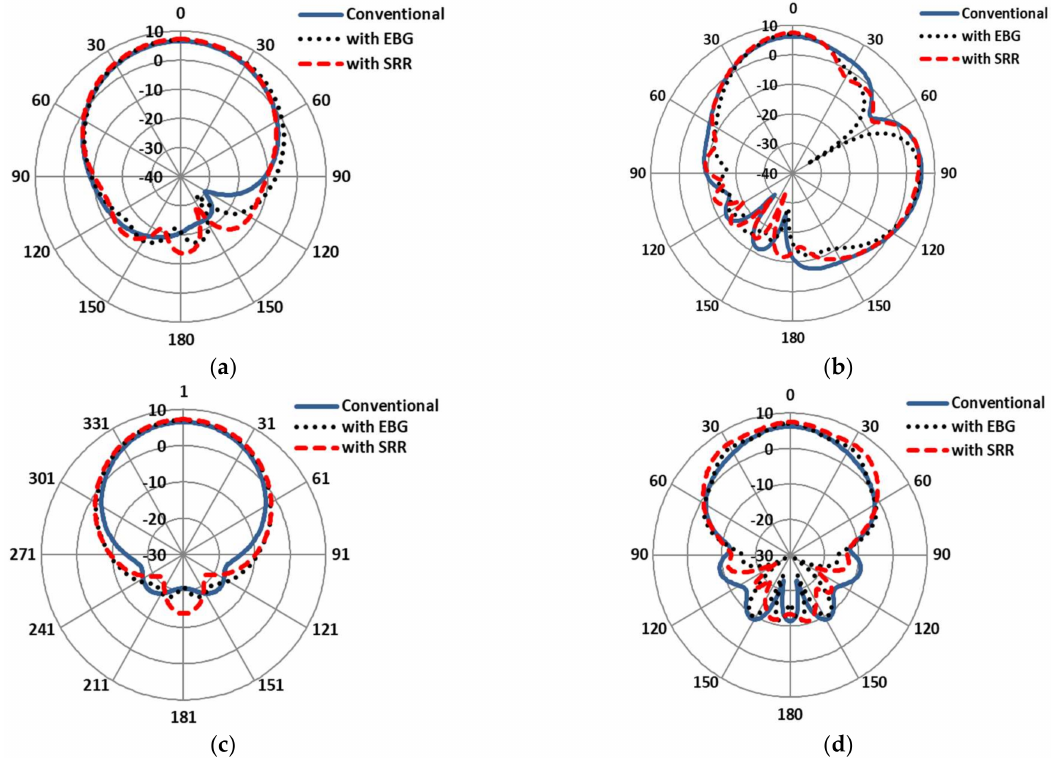
Figure 13. Gain patterns comparisons of conventional antenna with EBG- and SRR-based antennas under normal conditions. ( a ) E-plane at 2.4 GHz. ( b ) E-plane at 5.4 GHz. ( c ) H-plane at 2.4 GHz. ( d ) H-plane at 5.4